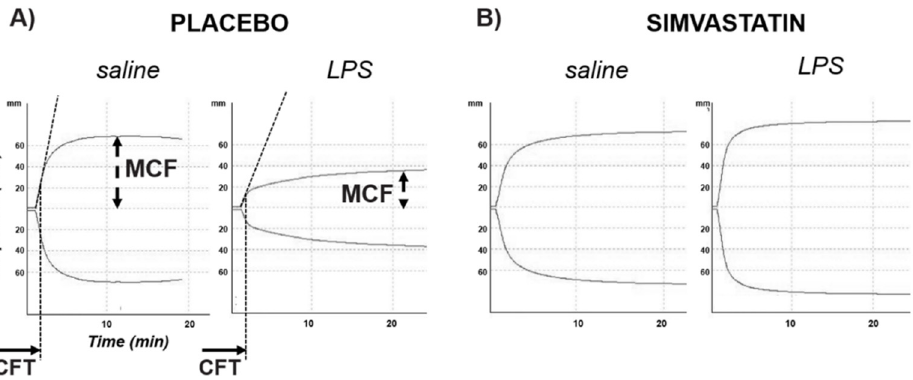
Figure 1. Representative ROTEM graphs showing the effect of LPS vs. saline on the in vitro clot formation in the placebo ( A ) and simvastatin treatment conditions ( B ). CFT, clotting formation time (sec); MCF, maximum clot firmness (units). More details on the curves are provided in Table 1. Table 1. Rotational thromboelastometry (ROTEM©) data on whole blood samples. Comparison of lipopolysaccharide (LPS) vs. saline in placebo and simvastatin (SMV) experimental condition. Results are presented as median (min–max)